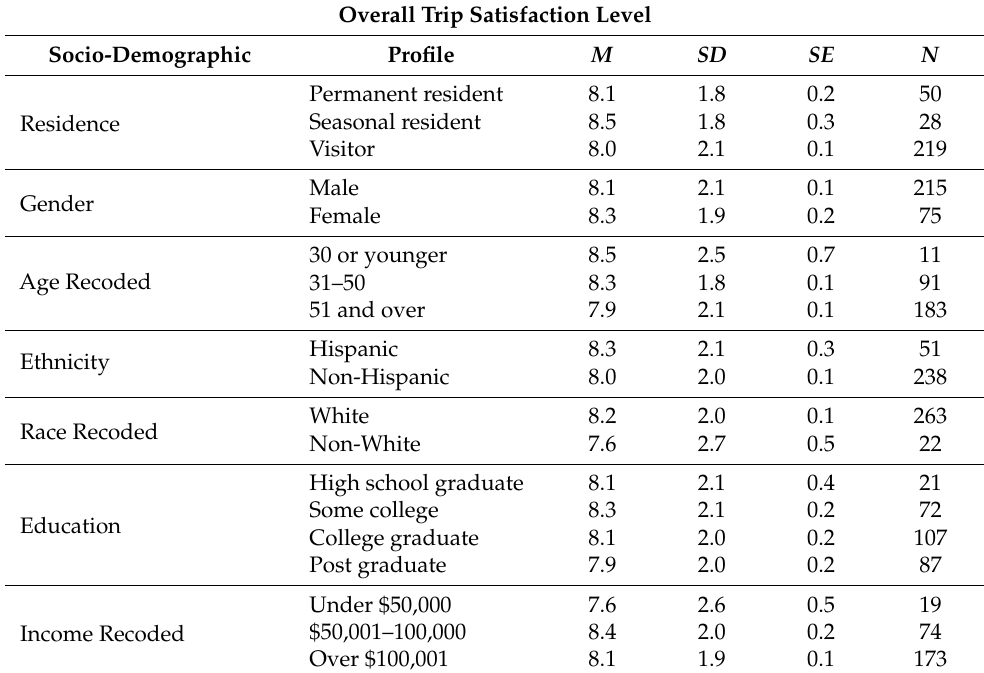
Table 3. Means of overall satisfaction level by socio-demographics across optional survey question responses.